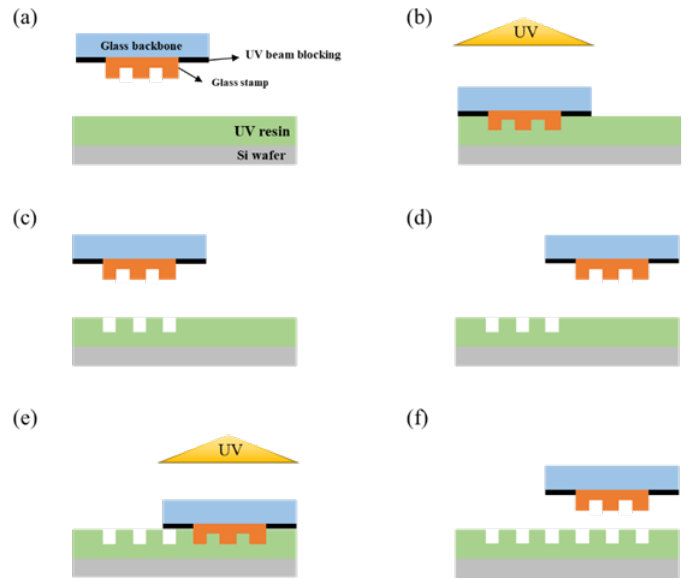
Figure 4. Schematic of the step-and-repeat NIL process. ( a ) The substrate is coated with resin, and the stamp is attached to the chuck. ( b ) When the pattern area and substrate are in contact, UV is irradiated, and the pattern is transferred to the substrate. ( c ) After UV irradiation, the demolding process takes place. ( d ) After the stamp is demolded, the stamp moves by the set value. ( e ) After the stamp moves by the set value, UV is irradiated when it contacts the substrate again. ( f ) After UV irradiation, the stamp is demolded, and the process is repeated.